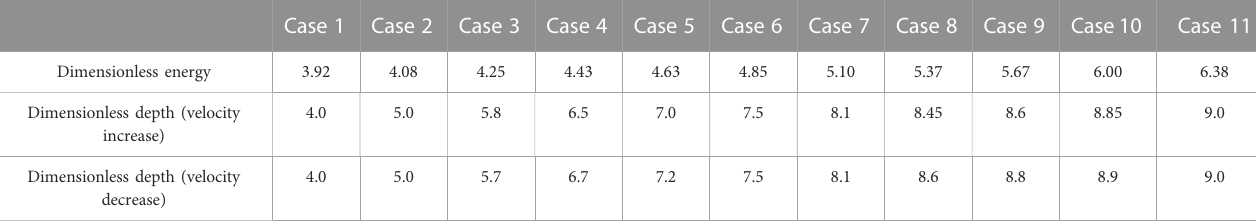
TABLE 2 Dimensionless results of variable quenching